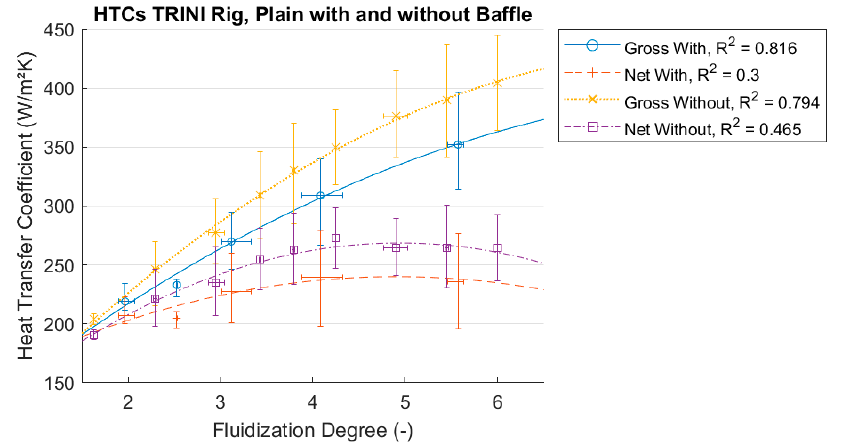
Figure 14. Comparison of the results with and without the use of a baffle, TRINI test rig, 146 µm particles.